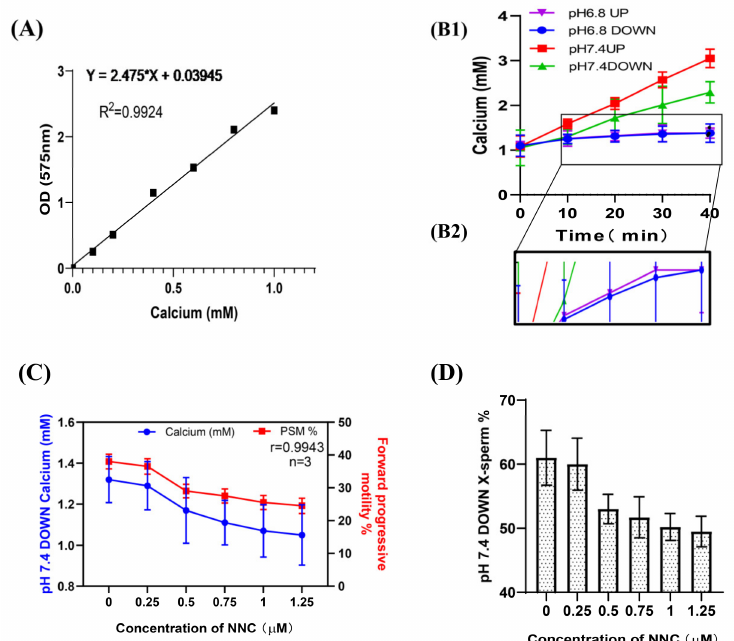
Figure 3. Changes in [Ca 2+ ]i concentration during sperm incubation. ( A ) Standard curve of calcium ion concentration in sperm; absorbance at OD575. ( B1 ) The [Ca 2+ ]i in the sperm changed with the incubation time. ( B2 ) A partially enlarged view of F1. ( C ) The calcium ion concentration of the lower-layer spermatozoa and the proportion of forwardly motile spermatozoa in the pH 7.4 dilution solution varied with the NCC concentration. ( D ) The proportion of X-chromosome-bearing sperm in the lower layer of the test tube in the pH 7.4 dilution varied with the concentration of